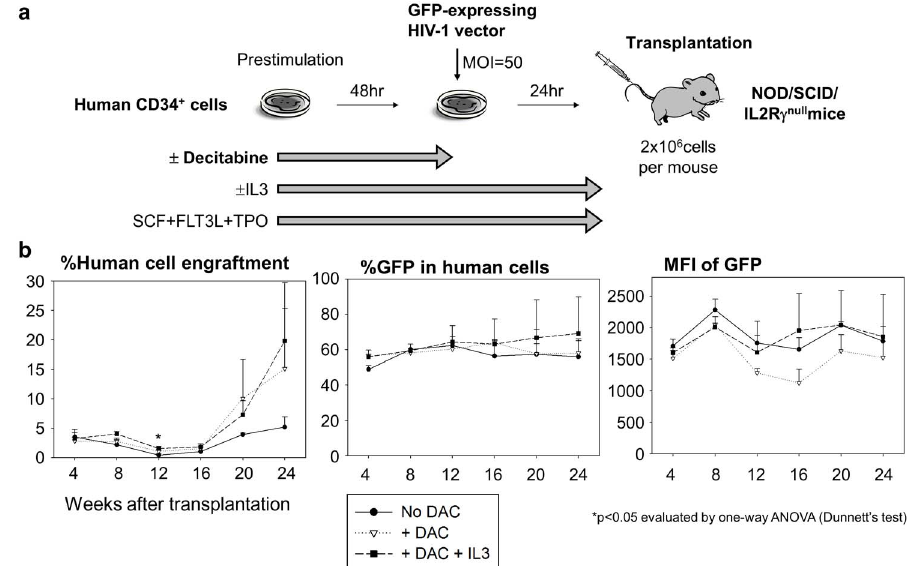
Figure 7. Decitabine modestly increased human cell engraftment in humanized xenograft mice. (a). To evaluate decitabine effects on long-term progenitor cells in vivo , we transduced human CD34 + cells after 48-hour prestimulation with and without decitabine (0.5 m M), and injected into sublethally-conditioned immunodeficient mice. (b). In 48-hour ex vivo decitabine exposure either with or without IL3, we observed equivalent %GFP and a tendency towards higher human cell engraftment at 20–24 weeks after transplantation, compared to no decitabine exposure (48-hour prestimulation without IL3).